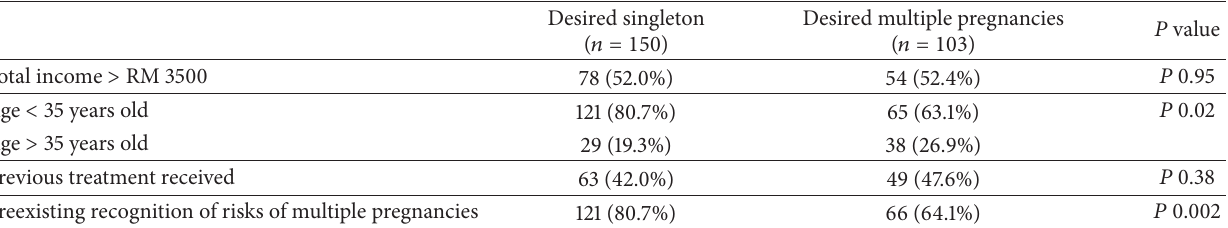
Table 2: Desire in order of pregnancy of 253 infertility patients and their partners with associated information. Desired